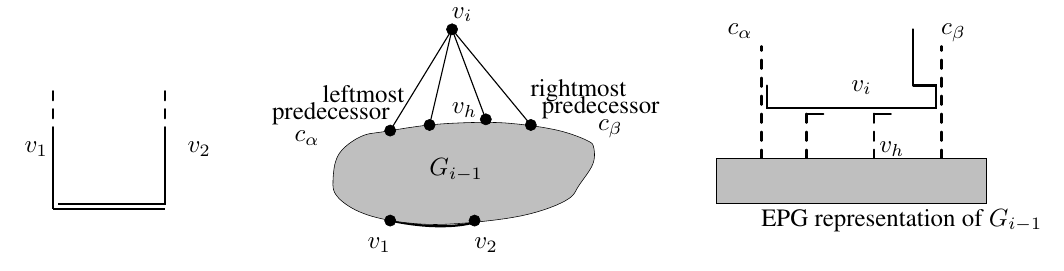
Fig. 2: An EPG representation obtained with the canonical